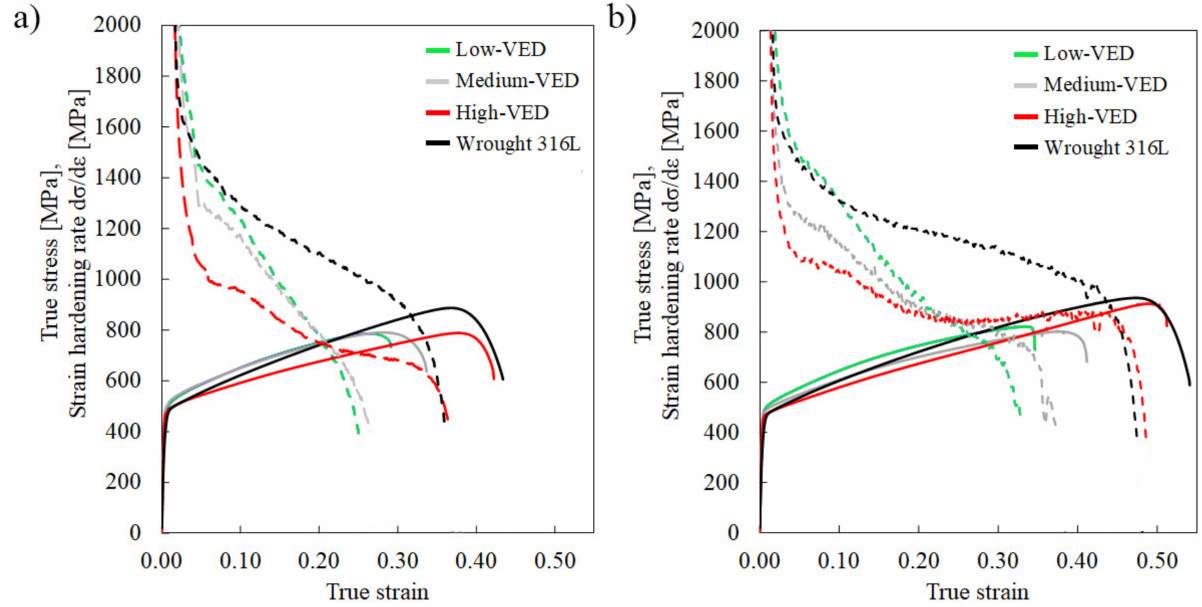
Figure 5. True stress vs. true strain (solid lines) and strain hardening rate curves (dashed lines) of the studied 316L strained at the ( a ) higher and ( b ) lower strain rate,